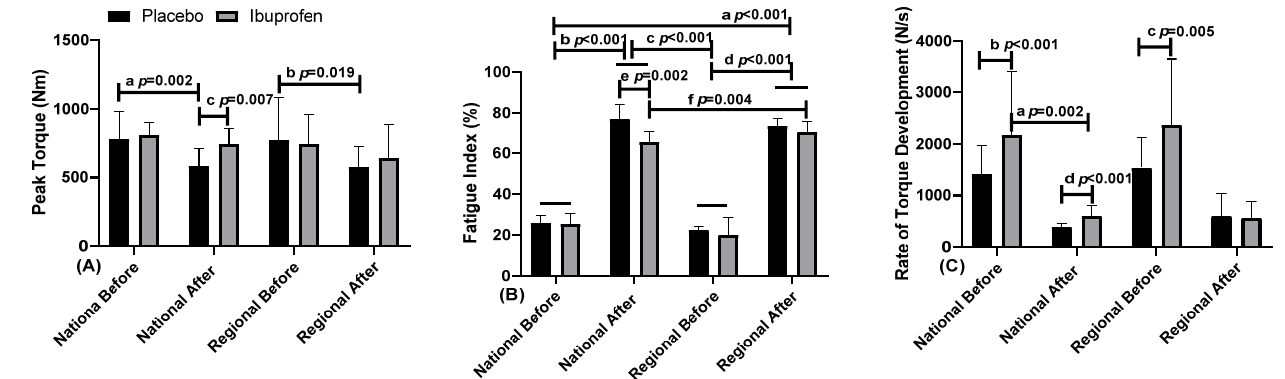
Figure 4. ( A ) Peak torque; ( B ) fatigue index; ( C ) rate of torque development in the use of placebo (PLA) and ibuprofen (IBU) at the regional and national levels of training. Legend: * (Letters) p <